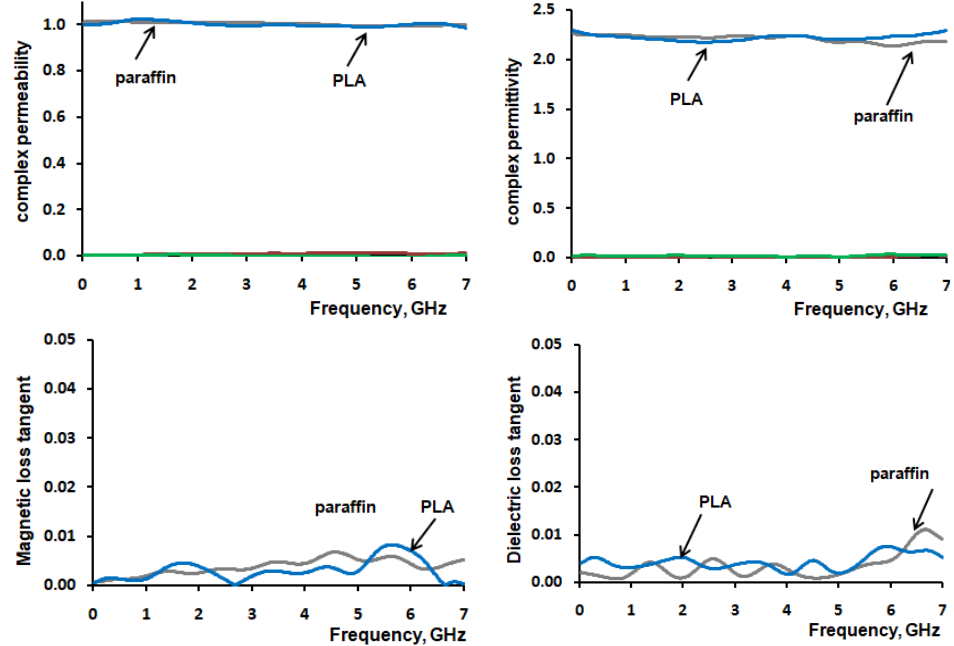
Figure 7. The complex permeability, complex permittivity, magnetic loss and dielectric loss tangent of paraffin and PLA polymer.